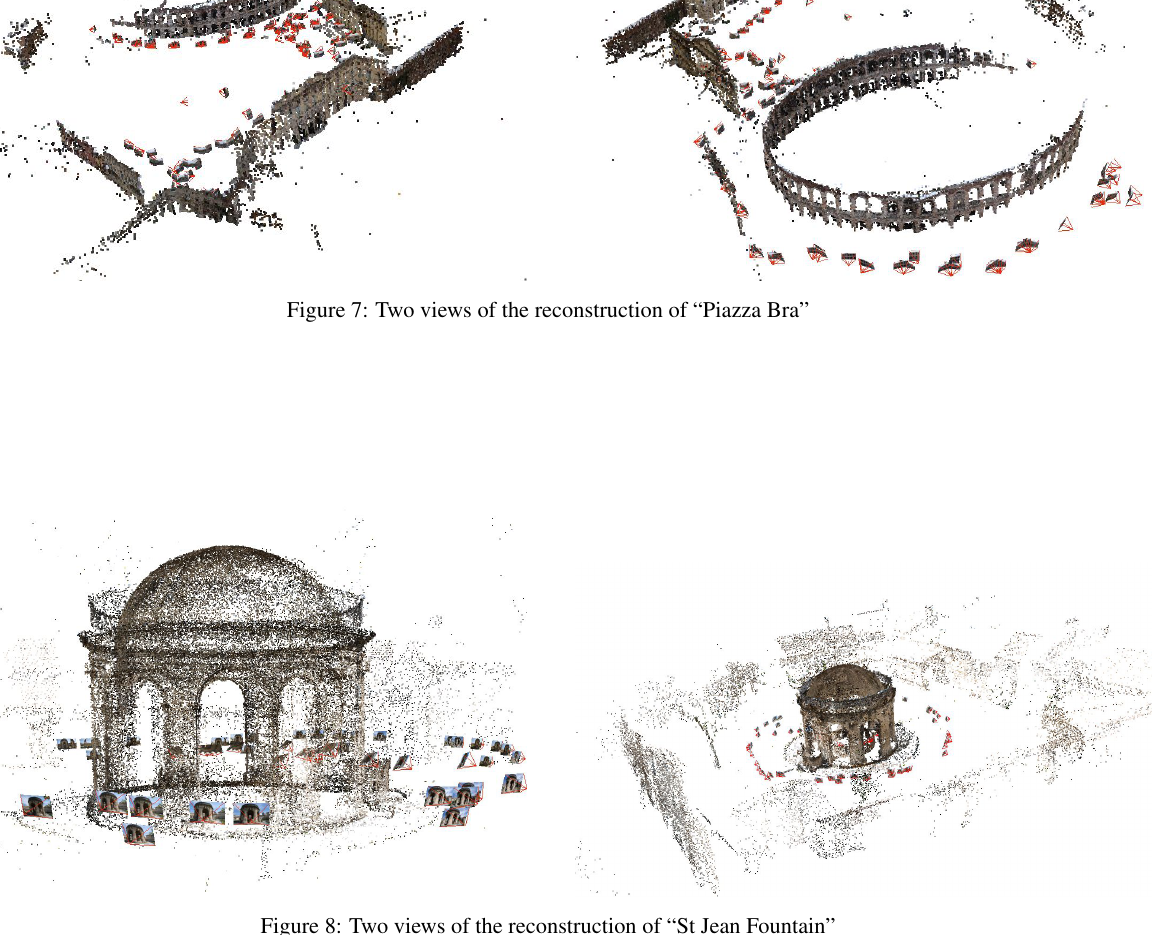
Figure 8: Two views of the reconstruction of “St Jean Fountain”